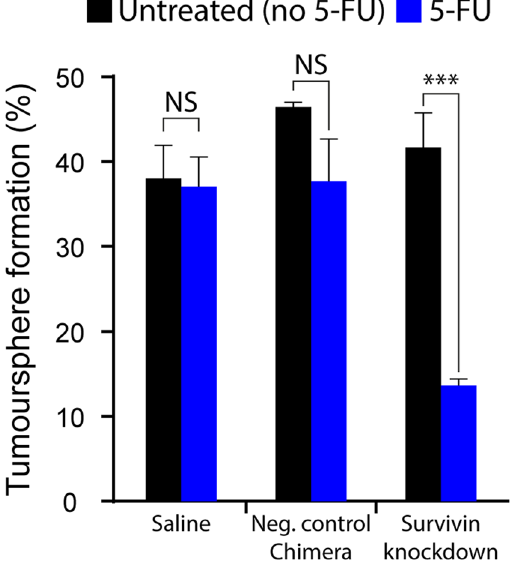
Figure 2. EpCAM aptamer mediated survivin knockdown transforms 5-FU into a colorectal cancer stem cell killer. Colorectal cancer HT-29 cells were first treated with EpCAM aptamer-survivin siRNA chimera for 24 hours followed by treatment with 2 μ M 5-FU for 5 days. Tumoursphere formation assay was used to examine the self-renewal capacities of treated cells. The bar graph shows the estimated stem cell frequencies. Data shown are means ± SEM, n = 3. *** p < 0.001. NS, no statistically significant difference.